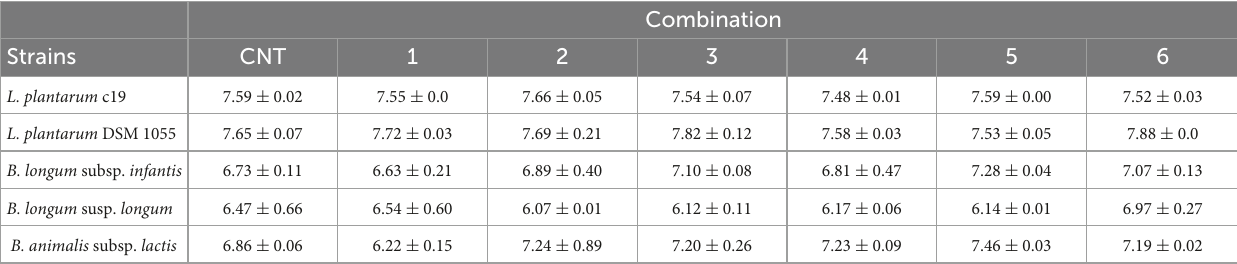
TABLE 2 Viable count (log CFU/ml) of US-treated bacteria compared to the control (untreated microorganism, CNT) immediately after the